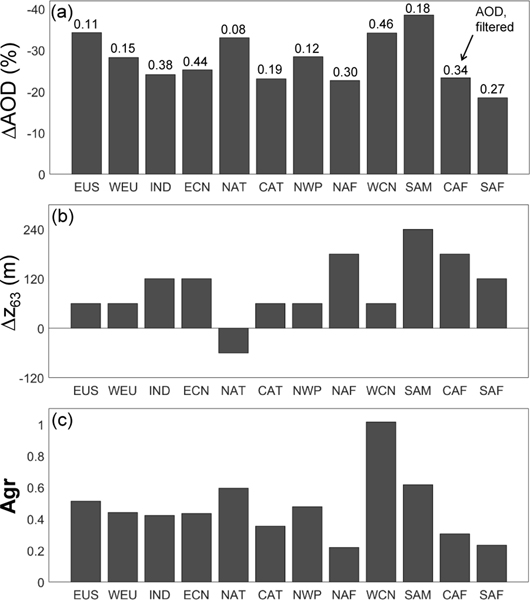
Regional changes in AOD and σ¯ with no filters compared with all filters: (a) percent reduction in AOD with numbers above the bars indicating mean filtered AOD, (b) difference in 63% extinction scale heights (all filters – no filters; Eq. B3), and (c) filter aggressiveness (Eq. B4) for 2007–2016 at night, all-sky. Samples at altitudes ≤ 0.039 km are excluded due to low sample counts.